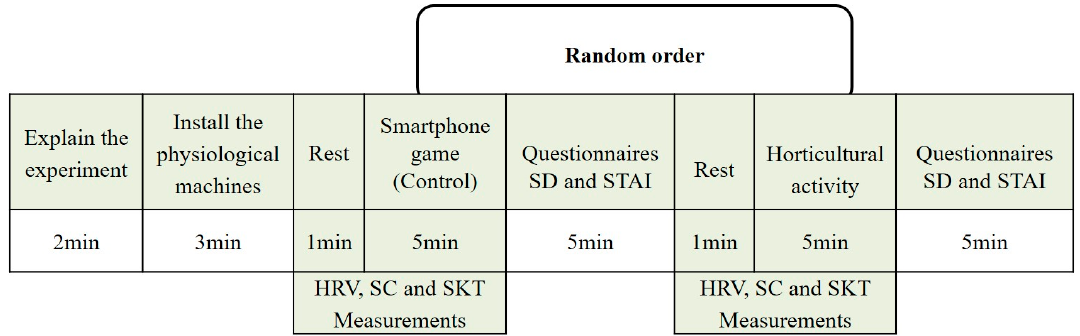
Figure 1. Study protocol. SD: semantic differential questionnaire; STAI: State–Trait Anxiety Inventory; HRV: heart rate variability; SC: skin conductance: SKT: skin temperature.